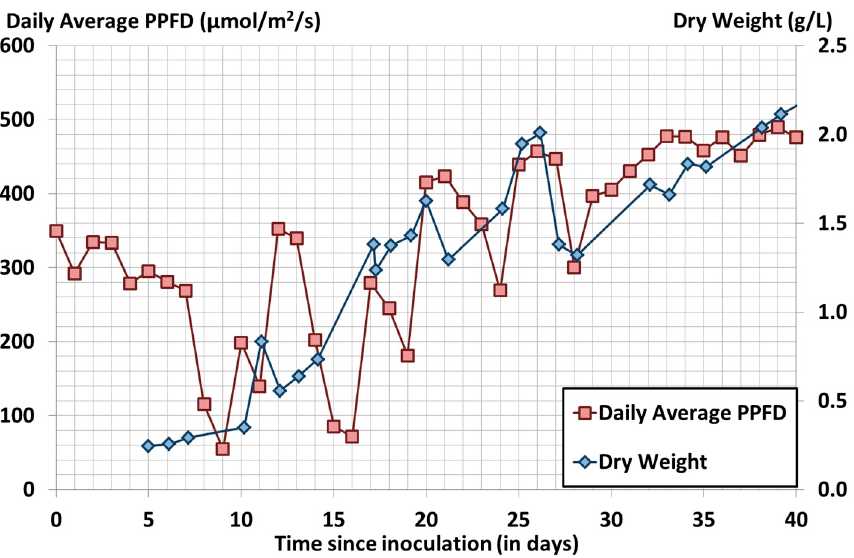
Figure 9. Daily average PPFD (measured inside the greenhouse) and dry weights for Spirulina grown in a 1000 L Camargue PBR. No replicates.